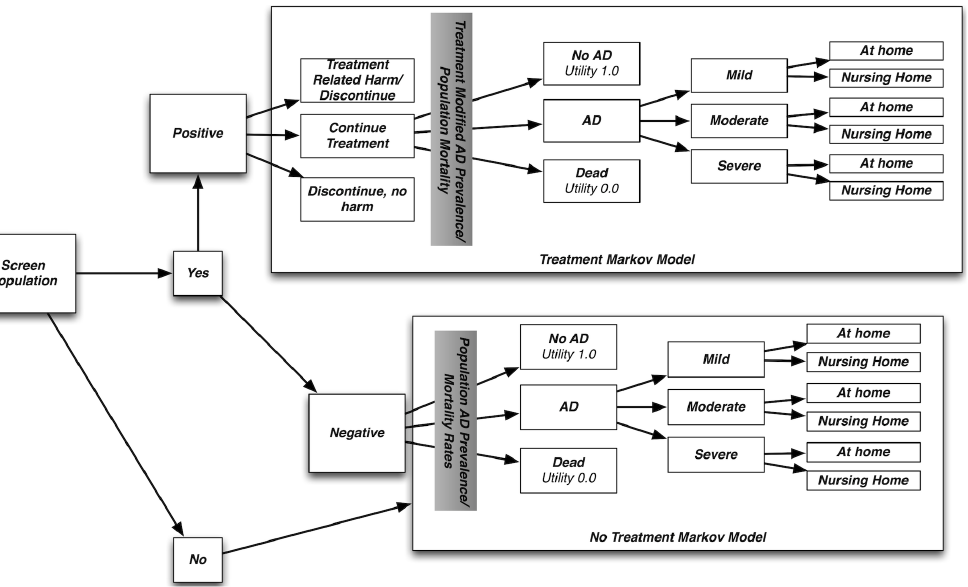
Figure 1. State change (Markov) model. How patients were selected for either the treatment or the untreated state change models and how state changes were assigned annually. Severity and living at home were hierarchically structured – once an individual arrived at the lowest level of the hierarchy (severe AD, living in a nursing home) an individual stayed in that state in subsequent